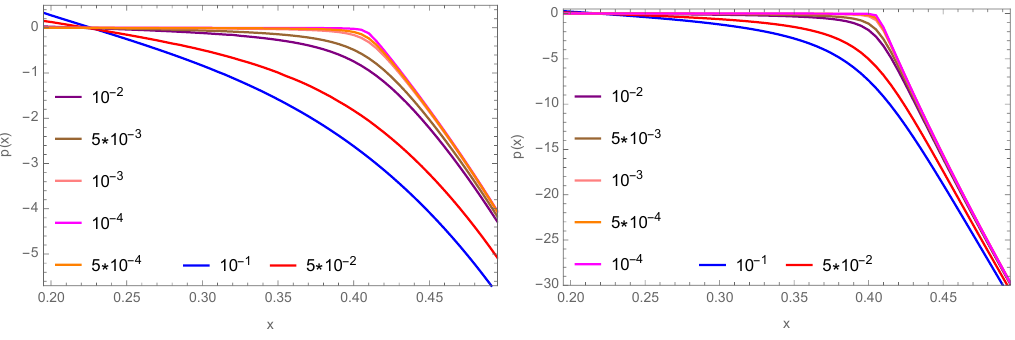
Figure 9 . Limiting curves for p ( x ) from the excited state (left) and micro-canonical ensemble (right), as one (cid:15) L varies from 10 (cid:0) 1 down to 10 (cid:0) 4 .